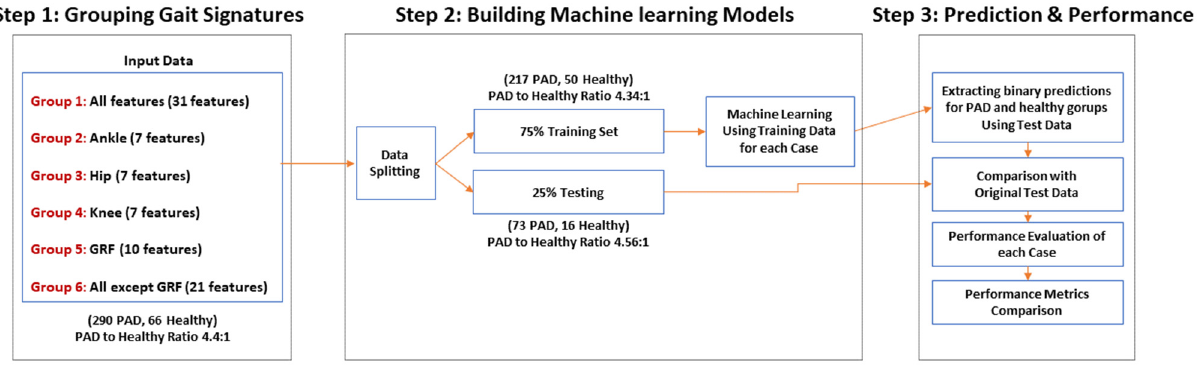
Figure 5. Flowchart showing the 3-step ML analysis method to identify PAD and extract the most valuable gait signatures for PAD diagnosis.